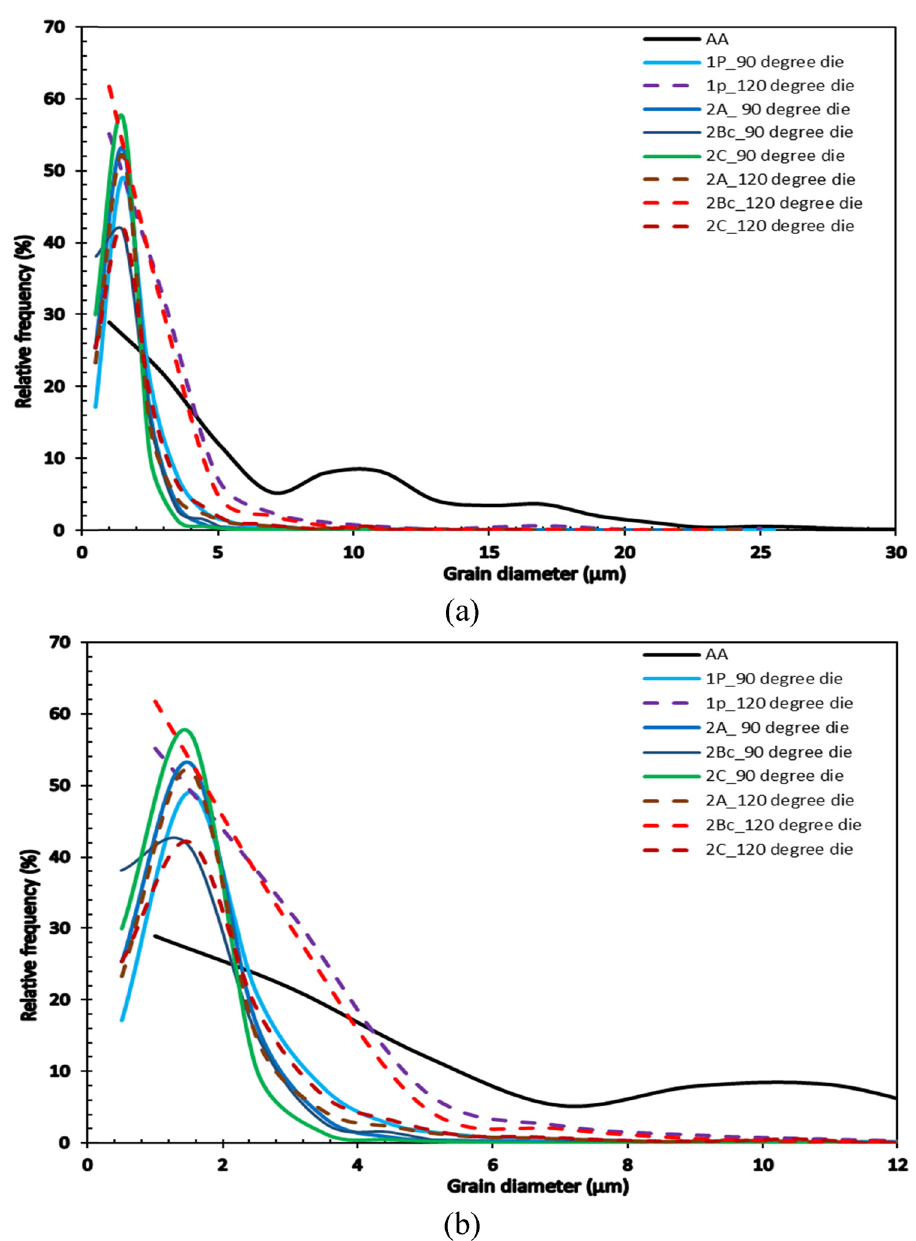
Figure 6: ( a ) Grain distribution calculated from EBSD data for the AA and ECAPed Mg billets using di ff erent die angles of ϕ = 90° and ϕ = 120° through di ff erent route types and ( b ) magni fi cation of the grain size